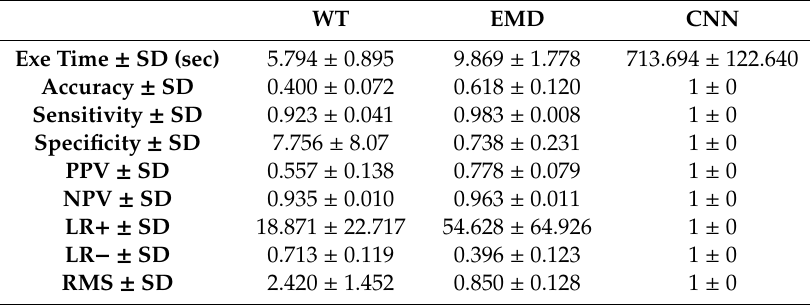
Table 1. Comparison between WT, EMD and CNN for Training phase.